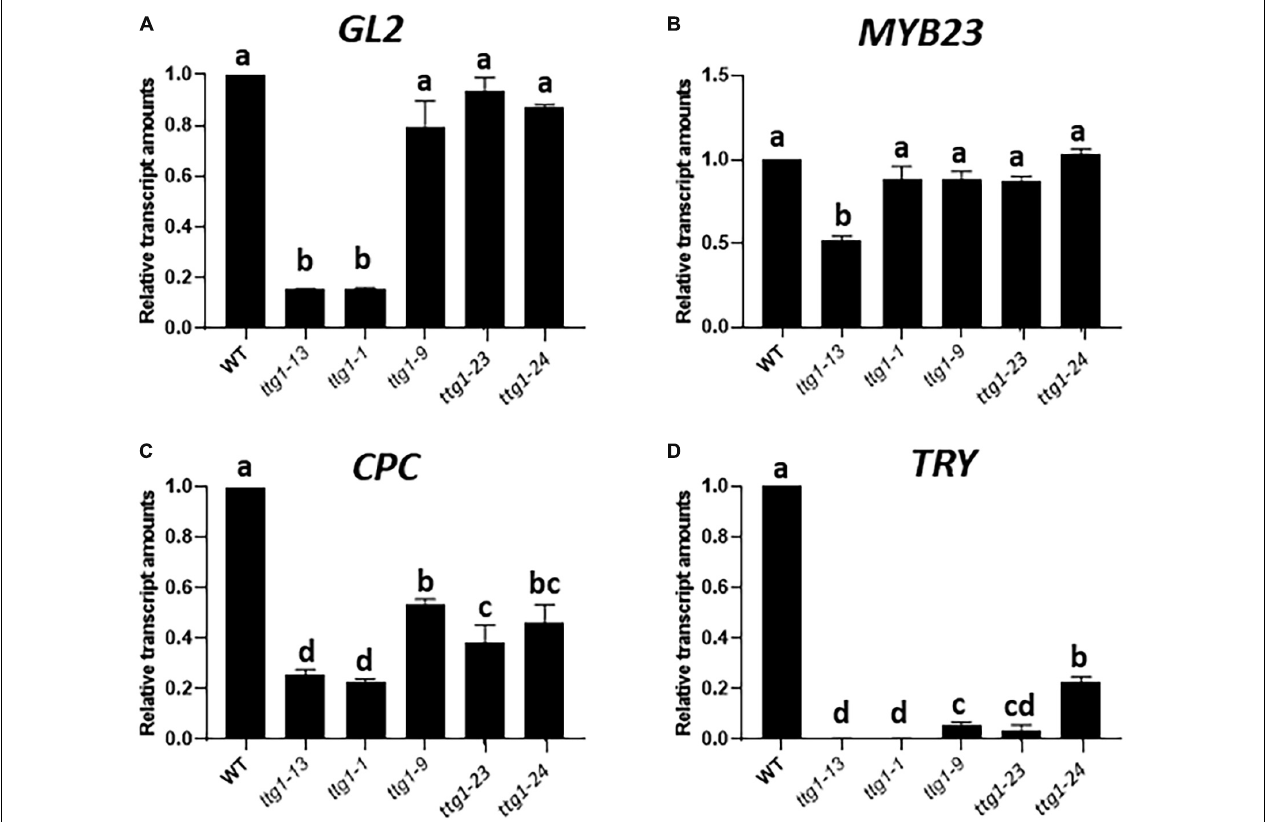
FIGURE 6 | Relative transcript amounts from (A) GL2 , (B) MYB23 , (C) CPC , and (D) TRY genes from seedling root tips of WT, ttg1-13, ttg1-1, ttg1-9, ttg1-23 , and ttg1-24 , determined with RT-qPCR. Three independent biological replicates were performed for each genotype. Error bars represent standard deviations. For each panel, bars marked with the same letter indicate values not significantly different; bars marked with different letters indicate values showing statistically significant differences ( P < 0.05; ANOVA